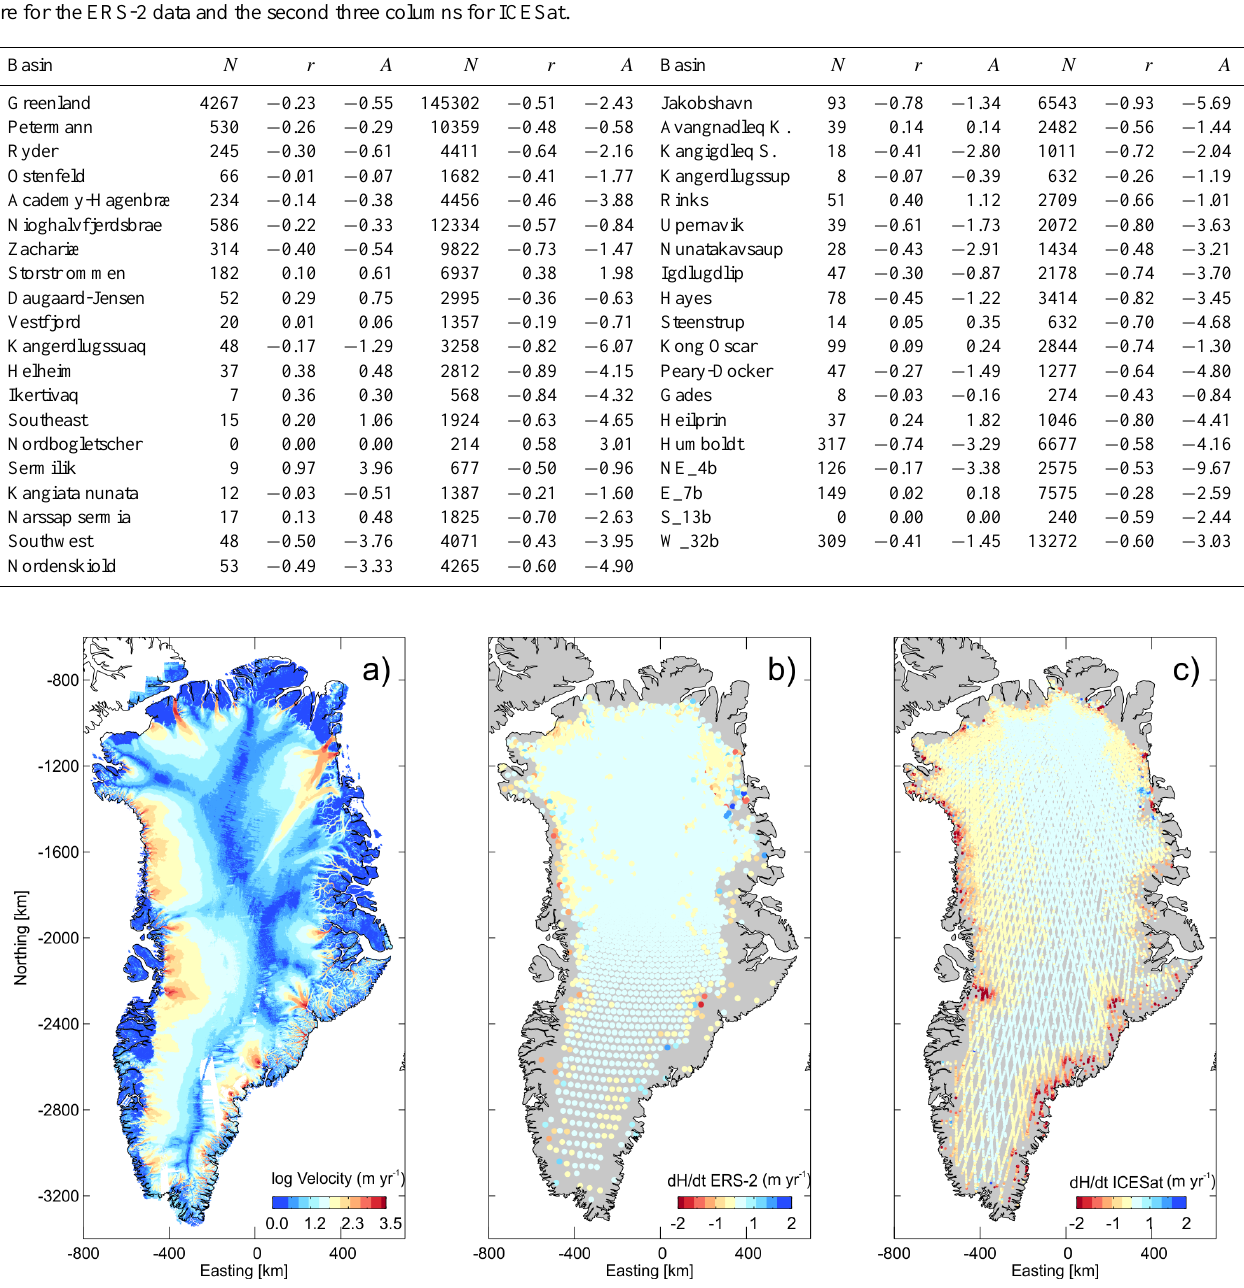
Table 1. Statistics of a linear regression between velocity and d H /d t , for 38 individual drainage basins (from (Rignot et al., 2008b) and the entire GrIS. N is the number of valid data points, r the Pearson correlation coefficient, and A the regression slope. The first three columns are for the ERS-2 data and the second three columns for ICESat.